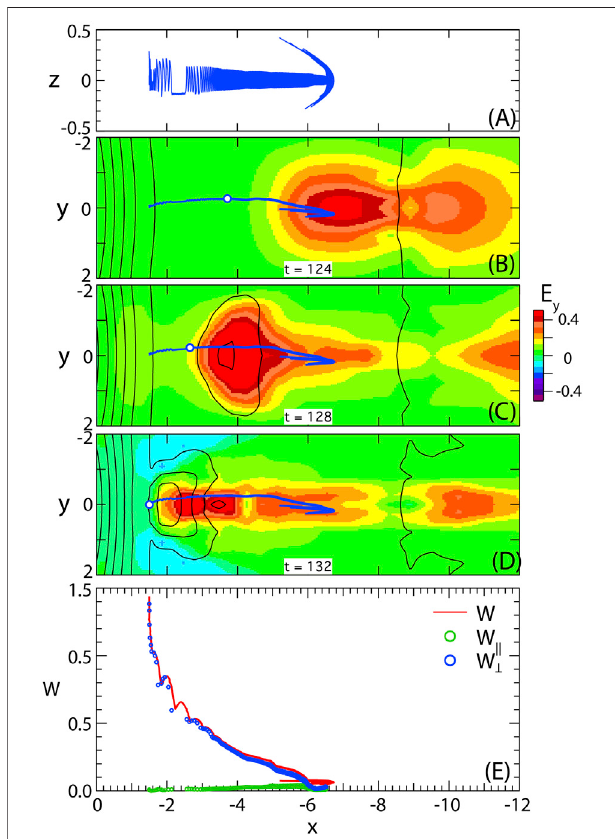
FIGURE 6 | Electron drift orbit contributing to the enhanced perpendicular fl uxes atthe inner location( − 1.5, 0,0), (A) projectionoftheorbit into the x , z plane, (B – D) orbit in the x , y plane, superposed on snapshots of the color-coded electric fi eld and particle location (white dot) at t = 124, 128, 132, (E) particle energy as function of x (red curve) together with the parallel (green circles) and perpendicular (blue circles) components.